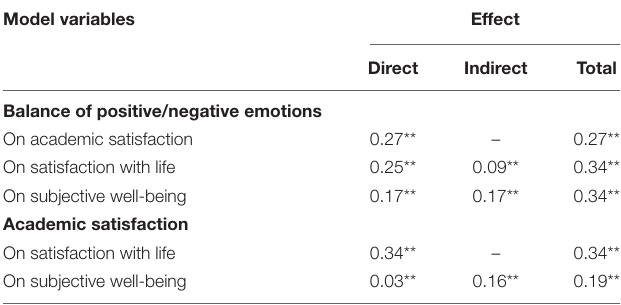
TABLE 3 | Total effects, direct and indirect, of the subjective well-being